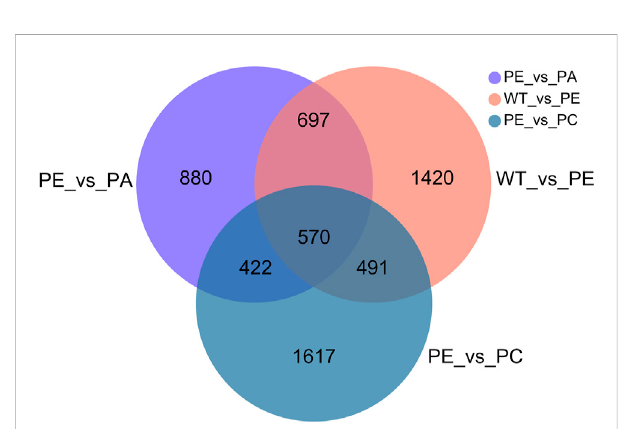
FIGURE 3 Venn diagram of the DEGs. Results from the WT_vs._PE, PE_vs._ PA and PE_vs._PC comparison groups were used for Venn analysis. Different colored circles represent the different comparison groups. WT_vs._PE: pink circle; PE_vs._PA: purple circle; PE_vs._PC: blue circle. The numbers indicate the genes that are common and unique to the different comparison groups. The sum of all the numbers inside the circle represents the total number of DEGs in the comparison group. The intersecting areas of the circles indicate the genes shared between the comparison